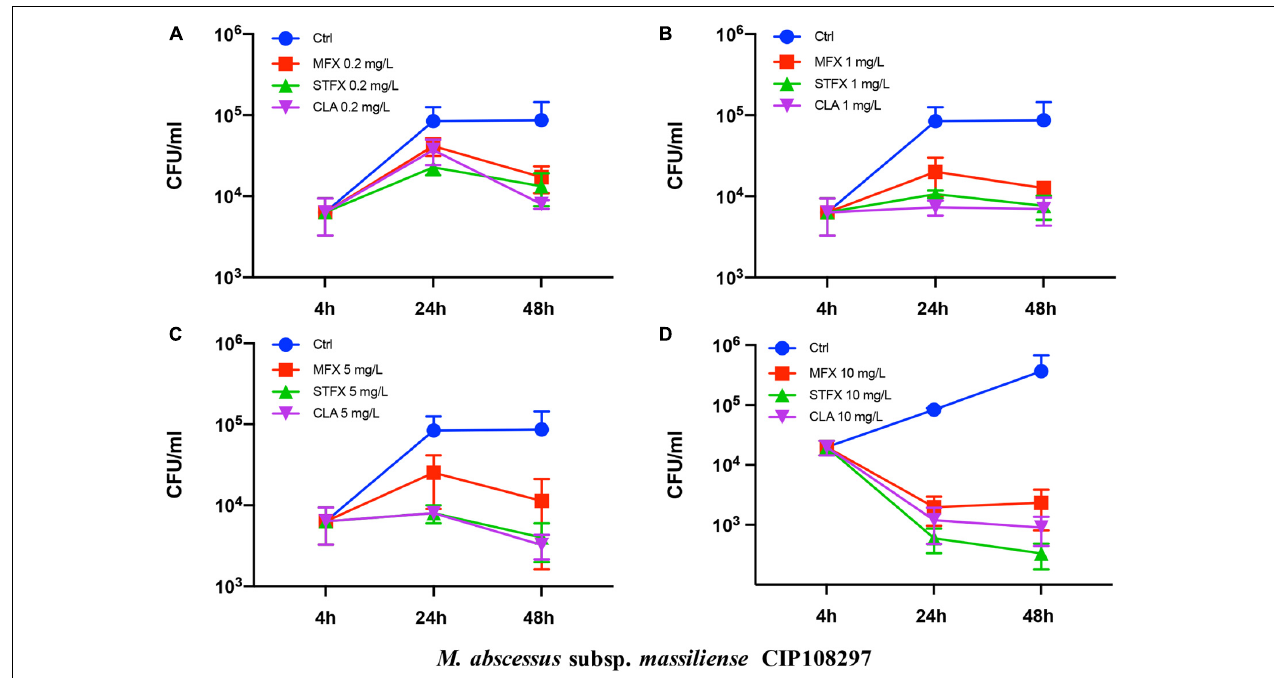
FIGURE 2 | Antimicrobial activities of sitafloxacin, moxifloxacin and clarithromycin against intracellular M. abscessus subsp. massiliense CIP 108297. Antibiotics at 0.2 (A) , 1 (B) , 5 (C) , and10 (D) mg/L final concentrations were added to cultures of M. abscessus -infected macrophages. Bacterial CFUs were quantified after drug-treated and control M. abscessus -infected cells were cultured for 4, 24, and 48 h. Ctrl, control; STFX, sitafloxacin; MFX, moxifloxacin; CLA, clarithromycin. TABLE 4 | Interaction of sitafloxacin with antibiotics frequently used to treat clinical M. abscessus infections.